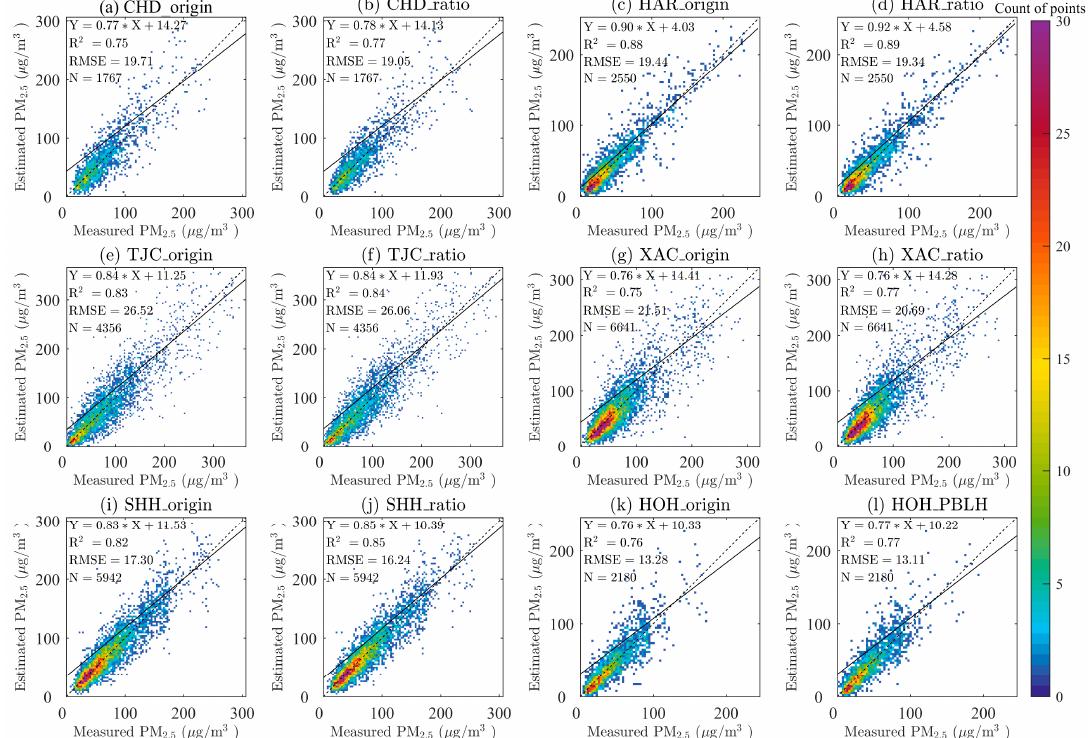
Figure 4. Cross validation results (including linear regression equation, decision coefficient (R 2 ), root mean square error (RMSE, μ g/m 3 ) and total count of test points (N)) between original situation: ( a , c , e , g , i , k ); and the corresponding revised situation under recommended vertical correction via: CALIOP ratio ( b , d , f , h , j ); or PBLH ( l ) in six selected provincial capitals. The six provincial capitals include Chengdu (CHD), Harbin (HAR), Tianjin (TJC), Xi’an (XAC), Shanghai (SHH) and Hohhot (HOH). The dashed lines represent the 1:1 lines for reference and the solid lines represent regression results.